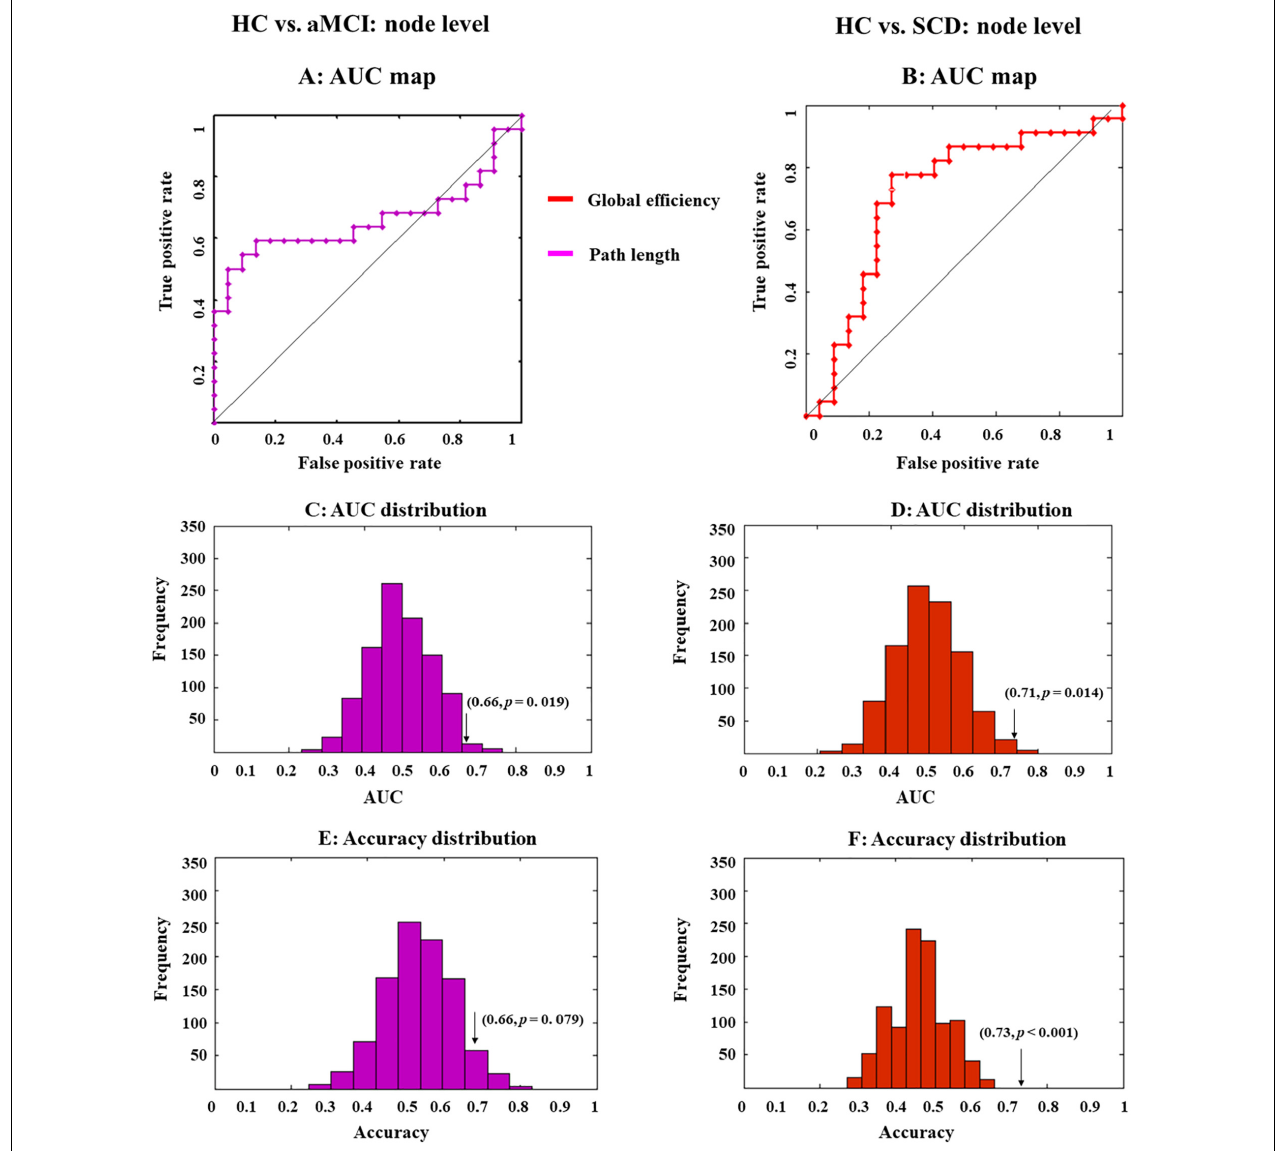
FIGURE 4 | Receiver operating characteristic (ROC) maps and area under the curve (AUC) or accuracy distribution of a classifier built on indexes at the nodal level. ROC maps show the classification performance (A,B) , where greater AUC corresponds to better performance. AUC and accuracy distribution maps (C–F) were built by permutation tests, during which group labels were randomly arranged 1,000 times. Arrows in the distribution maps marker AUC or accuracy based on real group labels.